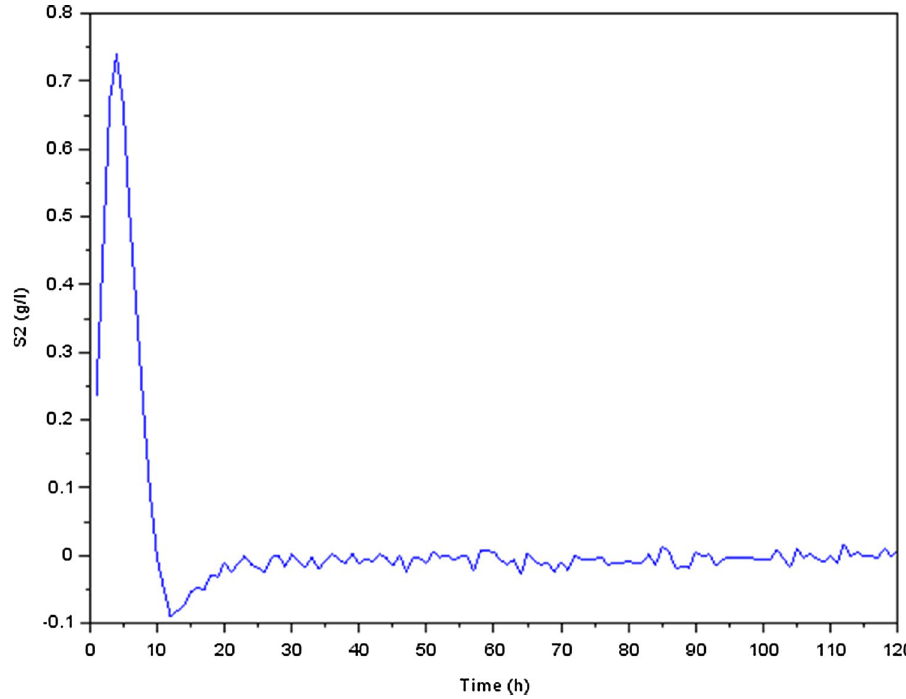
Figure 8. Variation of acetate concentration S 2 (g/l).